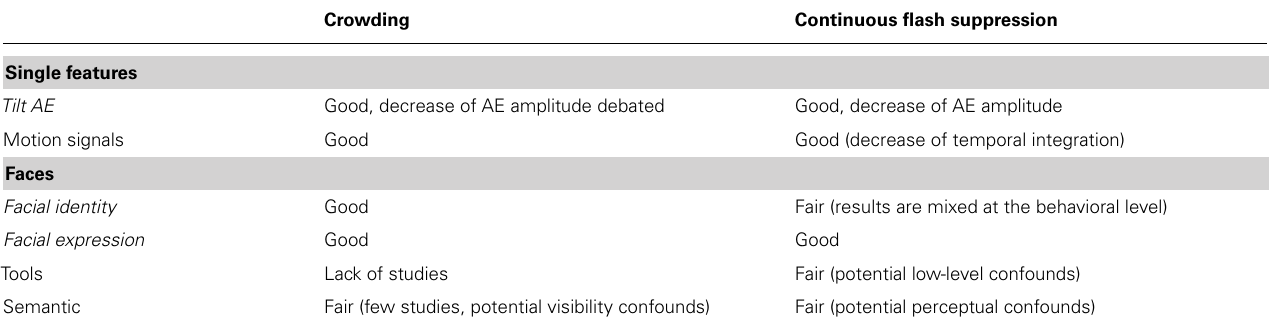
Table 2 | Summary of the comparison of crowding and CFS on the level of evidence regarding non-conscious processing of various